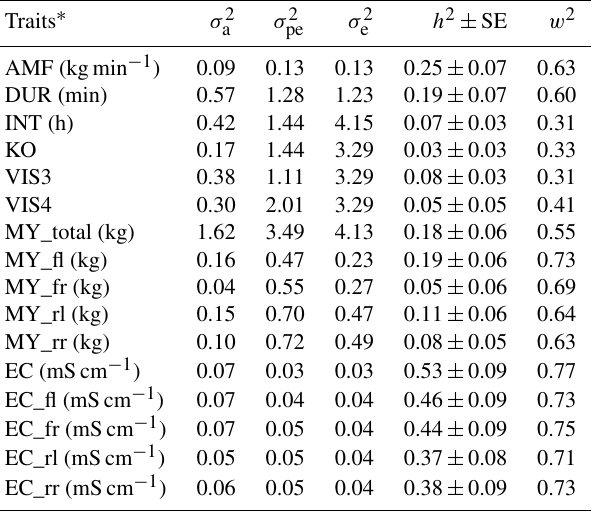
Table 4. Heritabilities ( h 2 ) with their corresponding SEs, additive genetic variances ( σ a ), permanent environmental variances ( σ 2 pe ), residual variances ( σ 2 e ), and repeatabilities ( w 2 ) for all